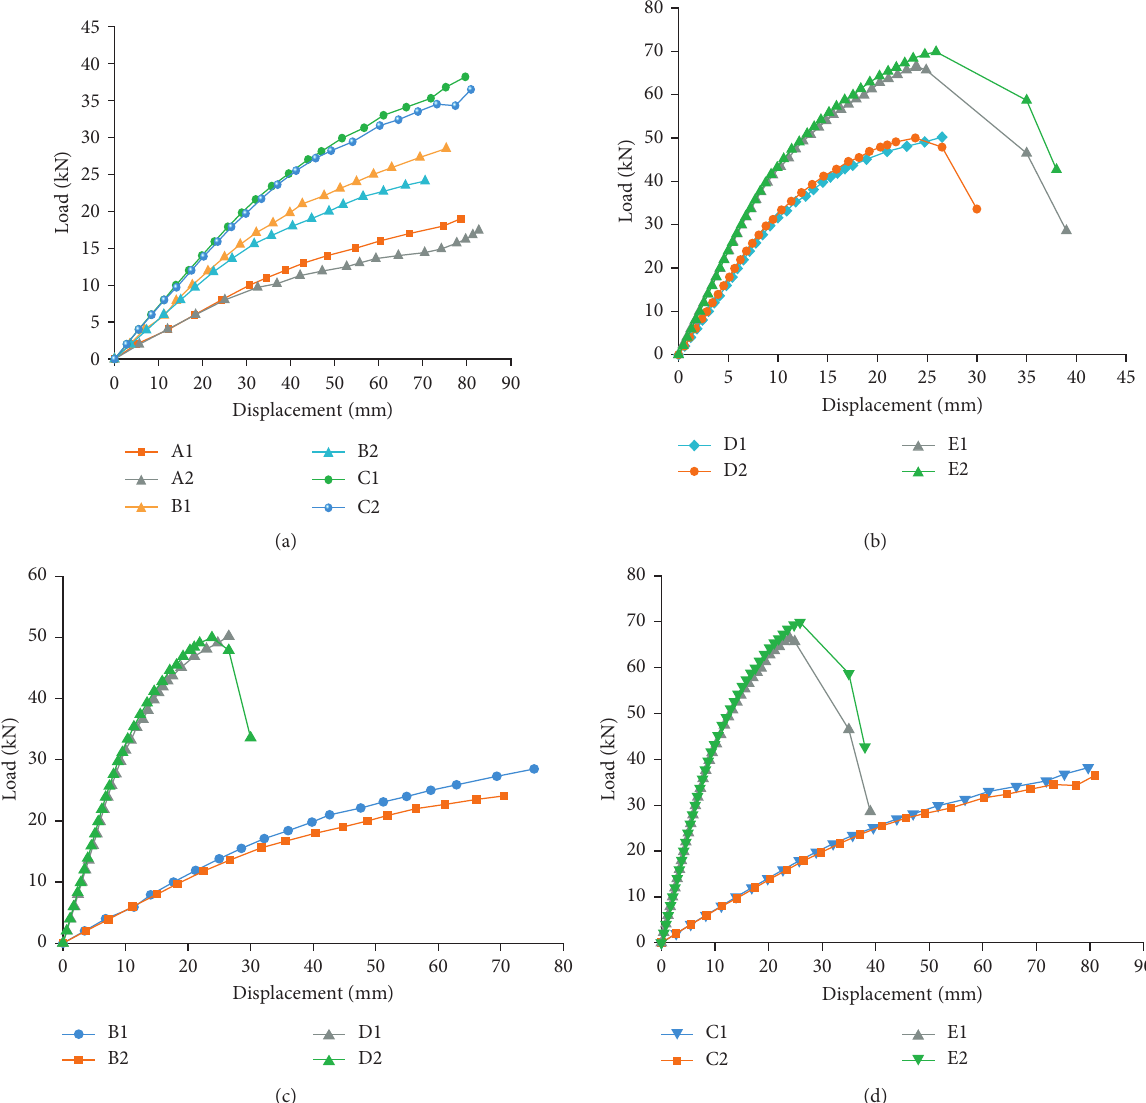
Figure 5: Comparison between load-displacement curves for each specimen. (a) Specimens A, B, and C. (b) Specimens D and E. (c) Specimens B and D. (d) Specimens C and E.